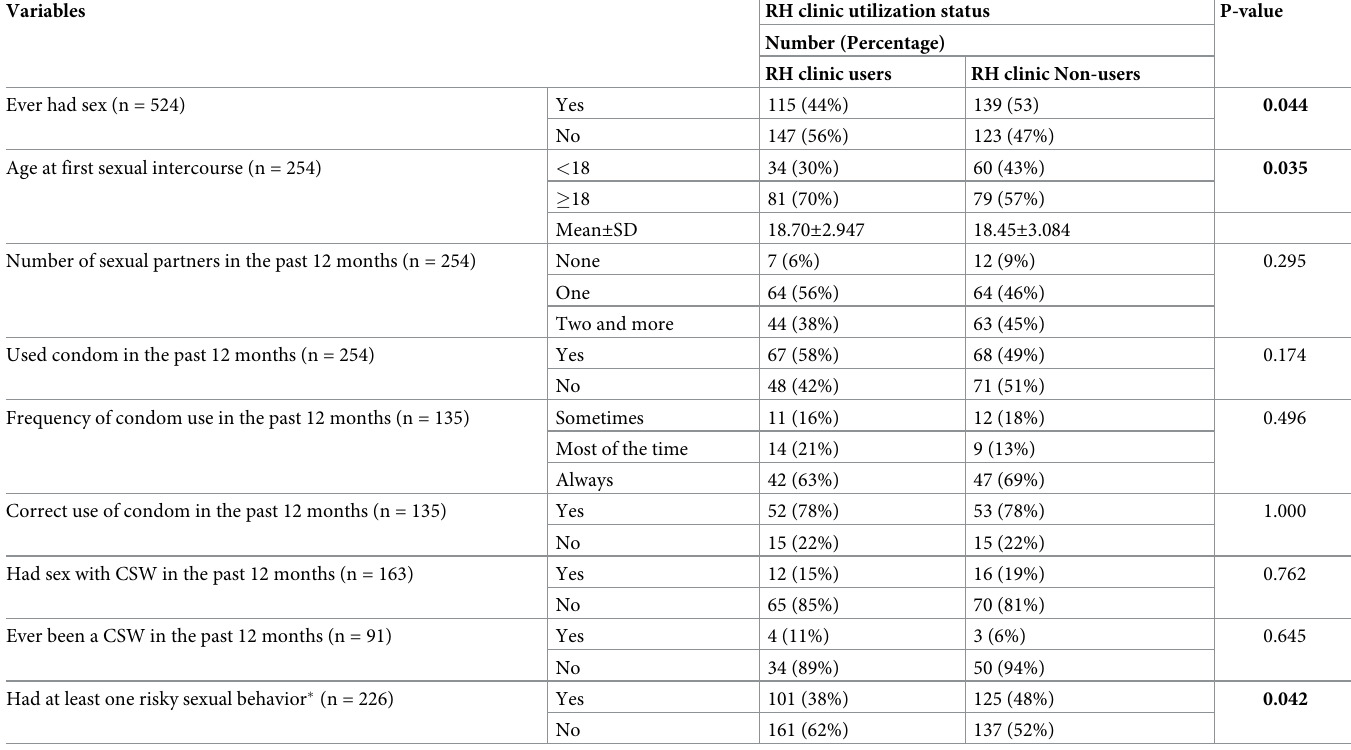
Table 2. Risky sexual behaviors of youth in Addis Ababa by youth center reproductive health clinics utilization status,